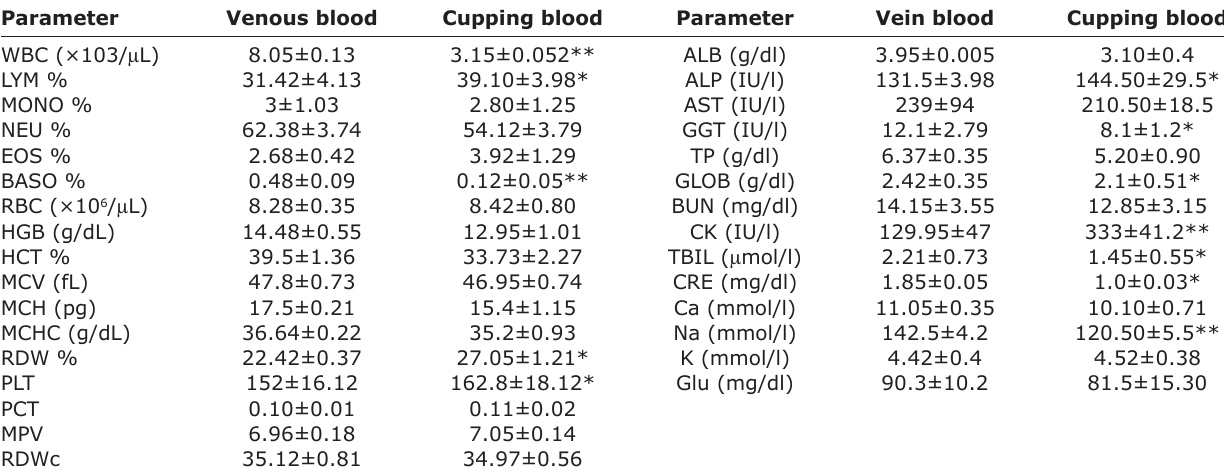
Table-3: Comparison between the hematological and biochemical parameters of venous and cupping blood samples of examined horses. Parameter